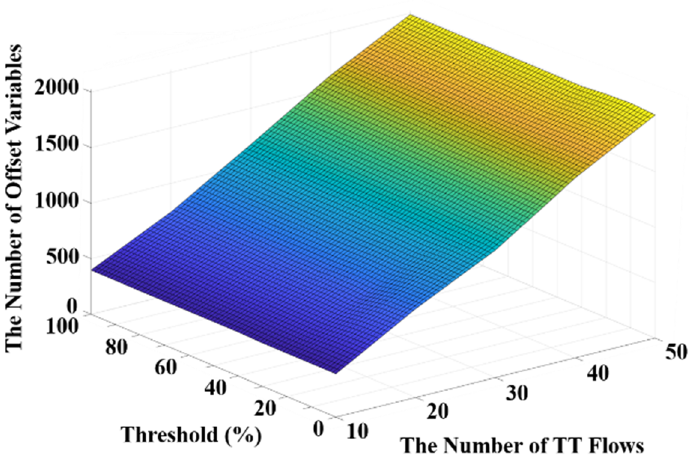
Figure 7. The frame offsets with thresholds and different numbers of flows.